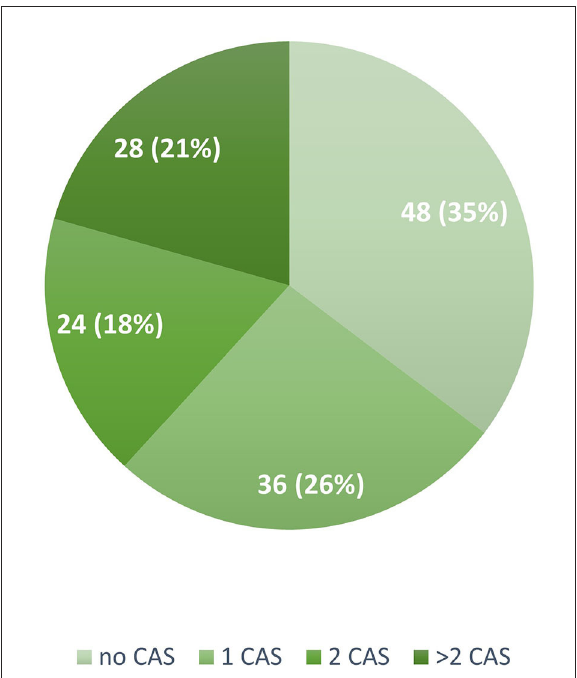
FIGURE1 Number and proportion of patients reporting none, one, two, or more cranial autonomic symptoms in the study population ( N = 136). CAS, Cranial Autonomic